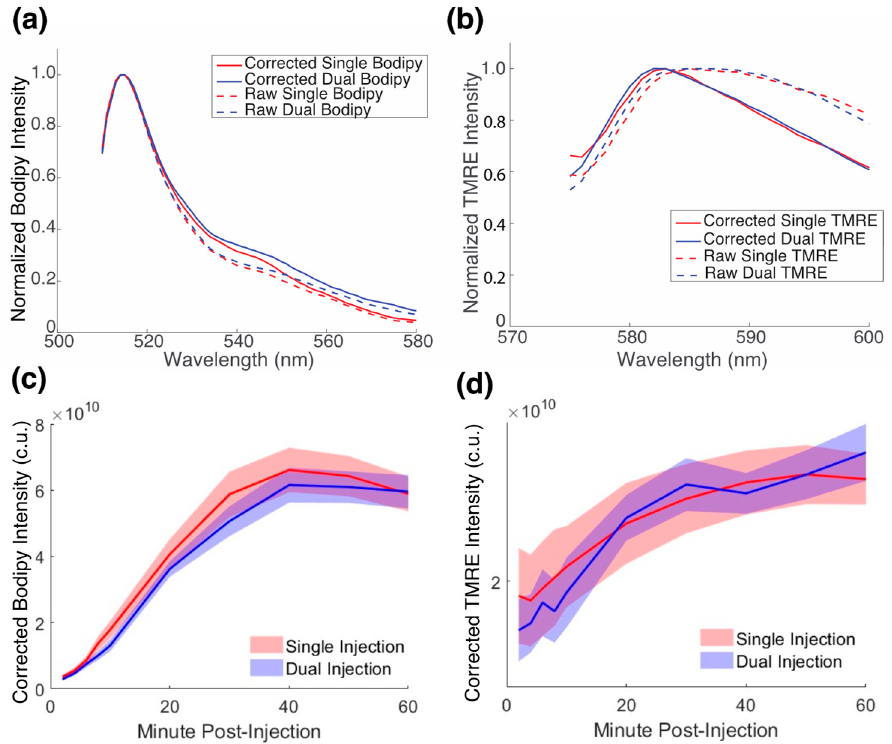
Figure 4. There is no biological crosstalk between TMRE and Bodipy FL C16. 4T1 mammary tumors were orthotopically injected into the fourth mammary fat pad in four cohorts of n = 9 Balb/c mice for the experimental studies. ( a ) Bodipy FL C16 and ( b ) TMRE spectra were measured and corrected with an inverse Monte Carlo algorithm and normalized to peak intensity for both individual and dual injections. Representative spectra are shown. ( c ) Single 200 μ M injections of Bodipy FL C16 and dual injections of 200 μ M Bodipy FL C16 and 75 μ M TMRE over a 60 ‐ min period, post ‐ injection, and ( d ) a single 75 μ M injection of TMRE and dual injections of 200 μ M Bodipy FL C16 and 75 μ M TMRE for a 60 min period, post ‐ injection. Intensities were averaged over nine animals, at each time point, and the shaded region represents standard (SE). p = n.s. for both comparisons. Intensity is reported in corrected units (c.u.).